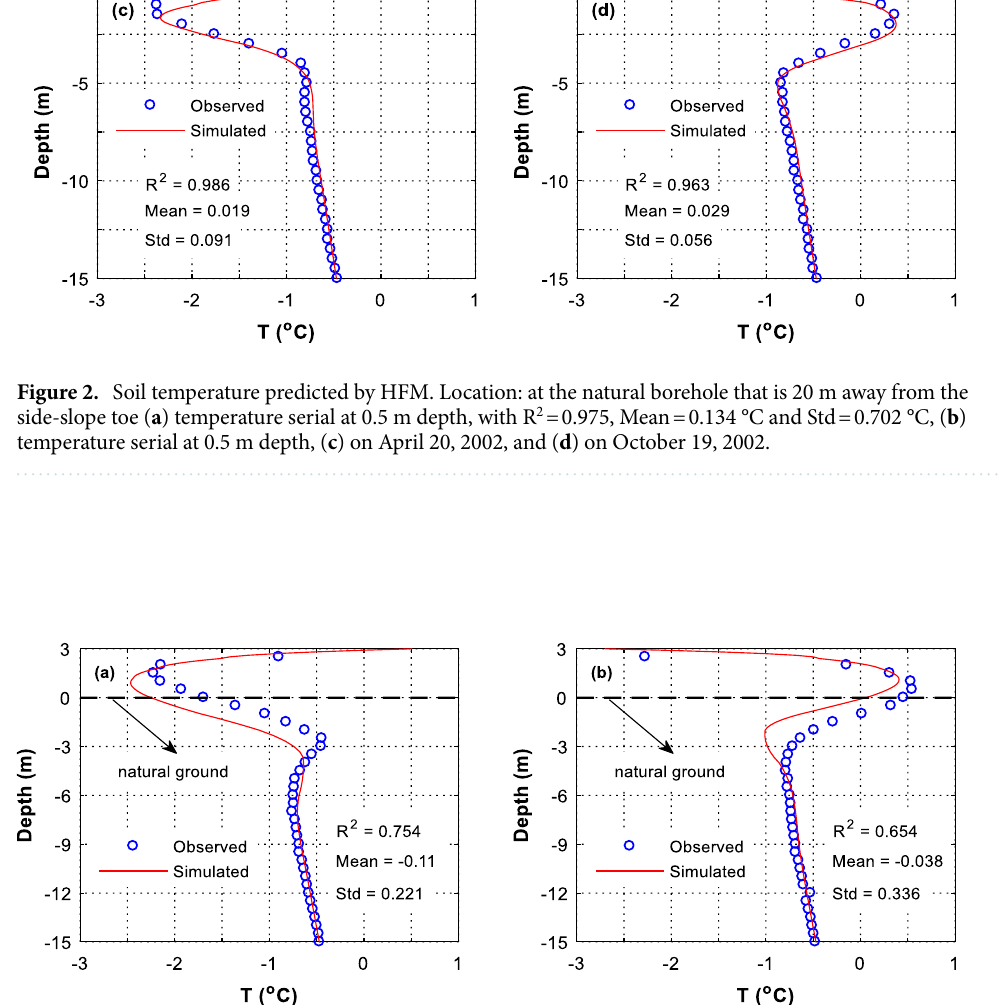
Figure 3. Soil temperature predicted by HFM. Location: at the central borehole. ( a ) on April 20, 2002, and ( b ) on October 19,